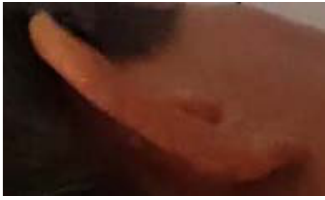
Figure 5. An example of how YOLO failed to find an ear from an